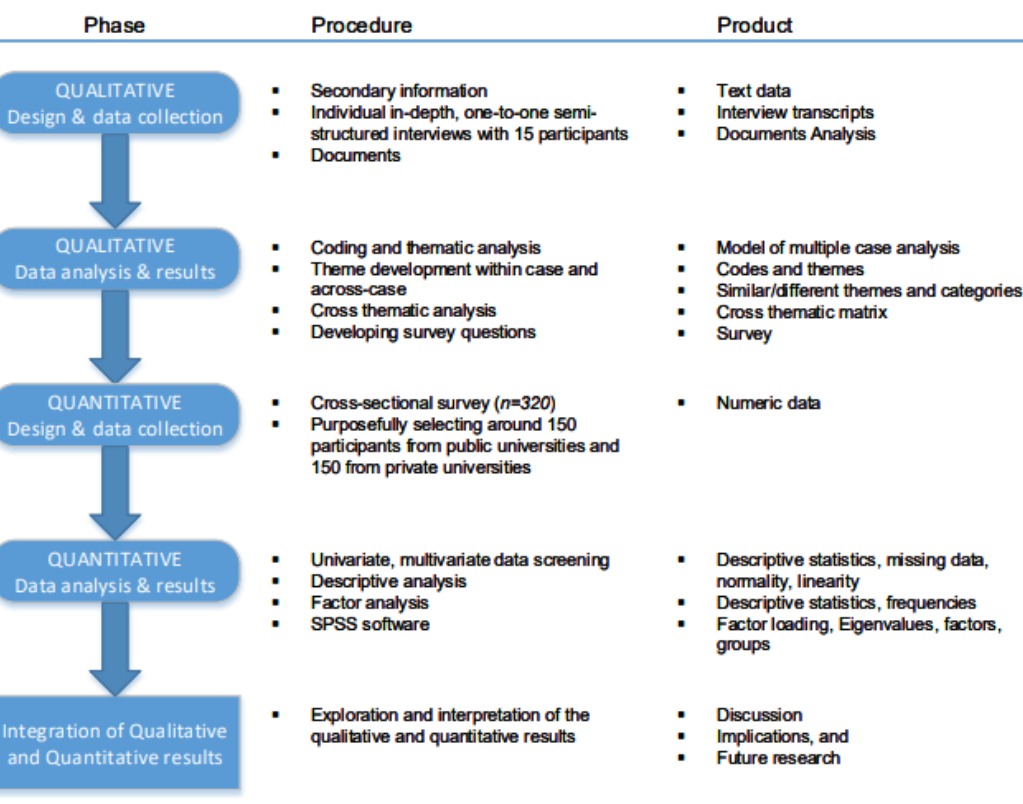
Figure 1. Model for sequential exploratory mixed approach design procedure and products.